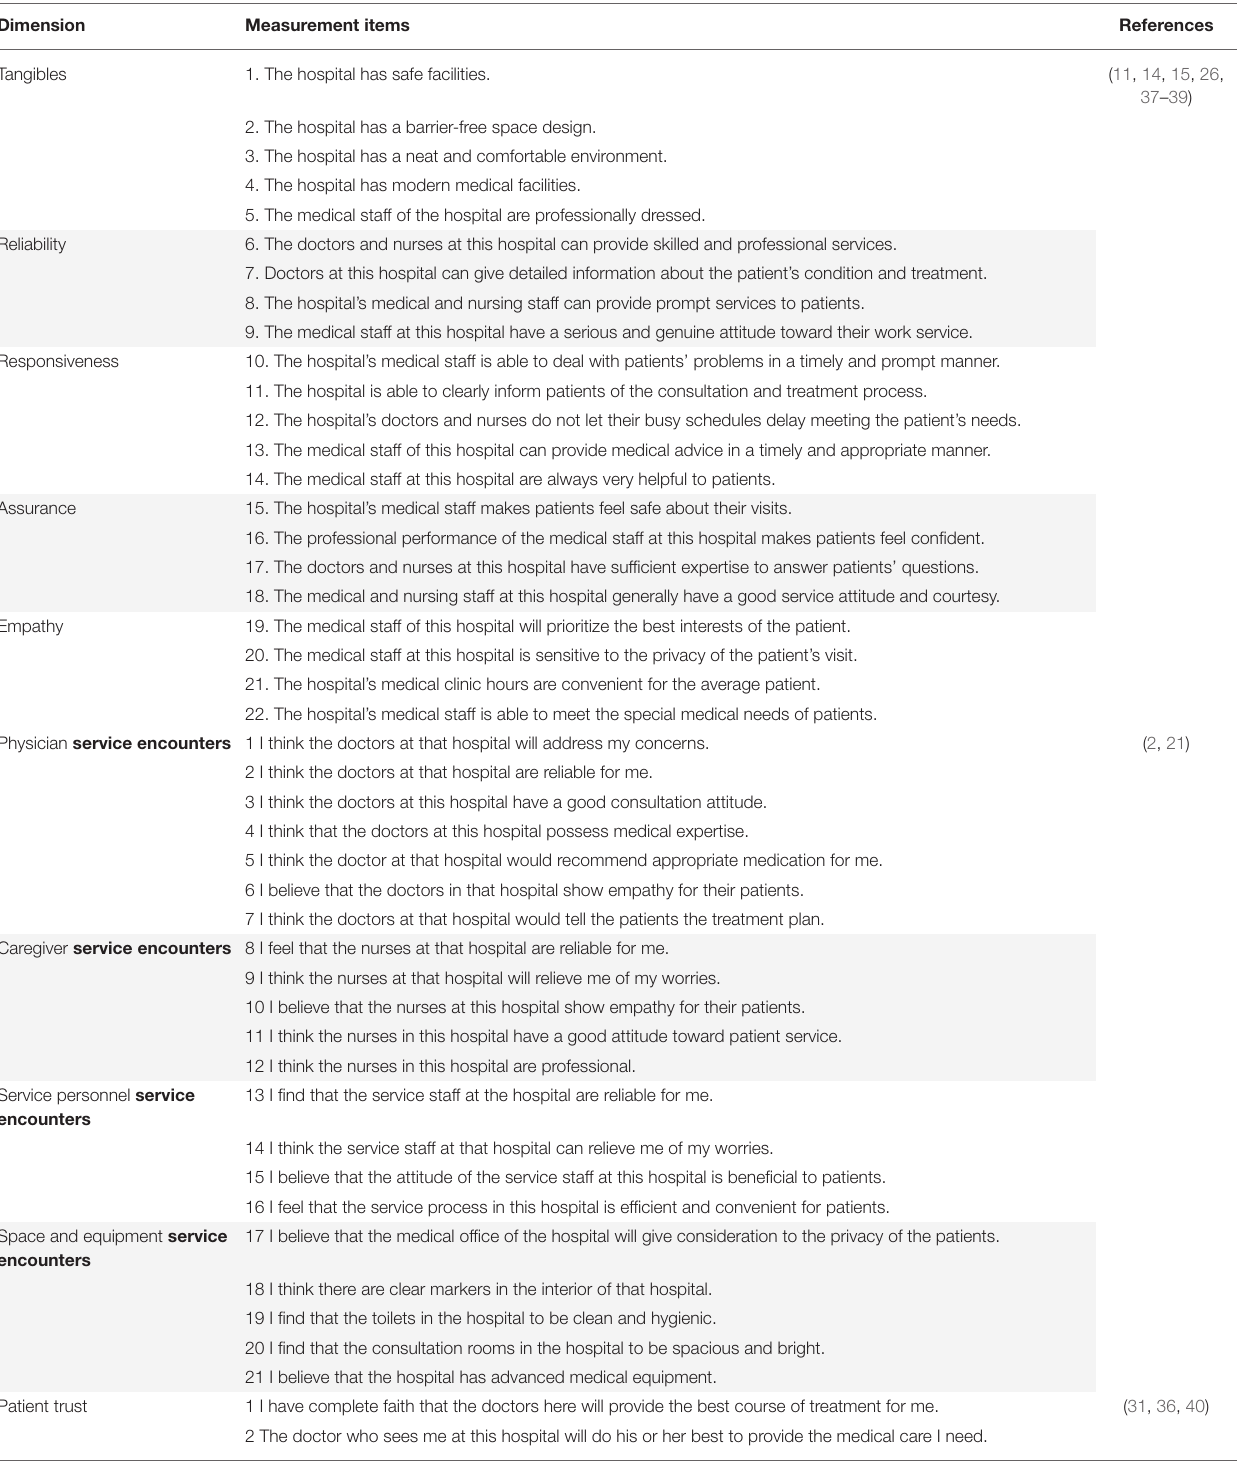
TABLE 1 | Hospital Service Encounter and Quality Measurement